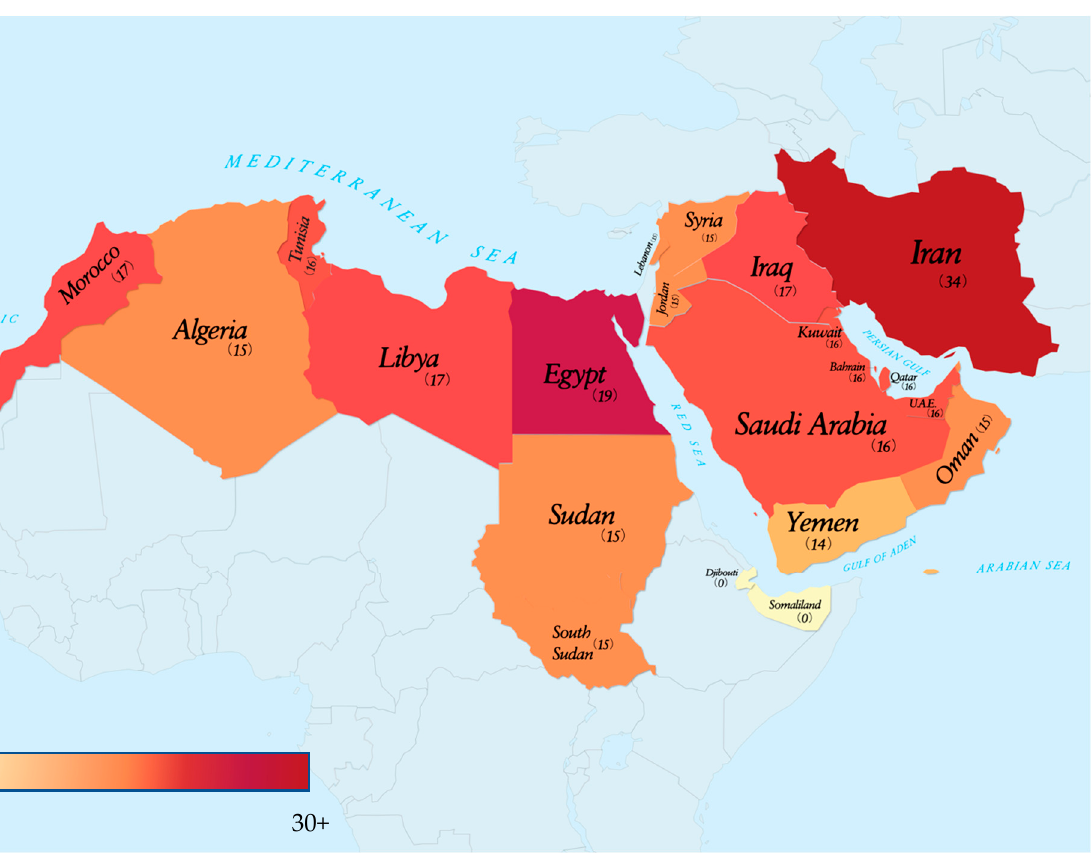
Figure 2. Heat map representing the number of research articles found for each country. The gradient bar scaled 0–30+, indicates the number of research studies found to have been conducted in the country.